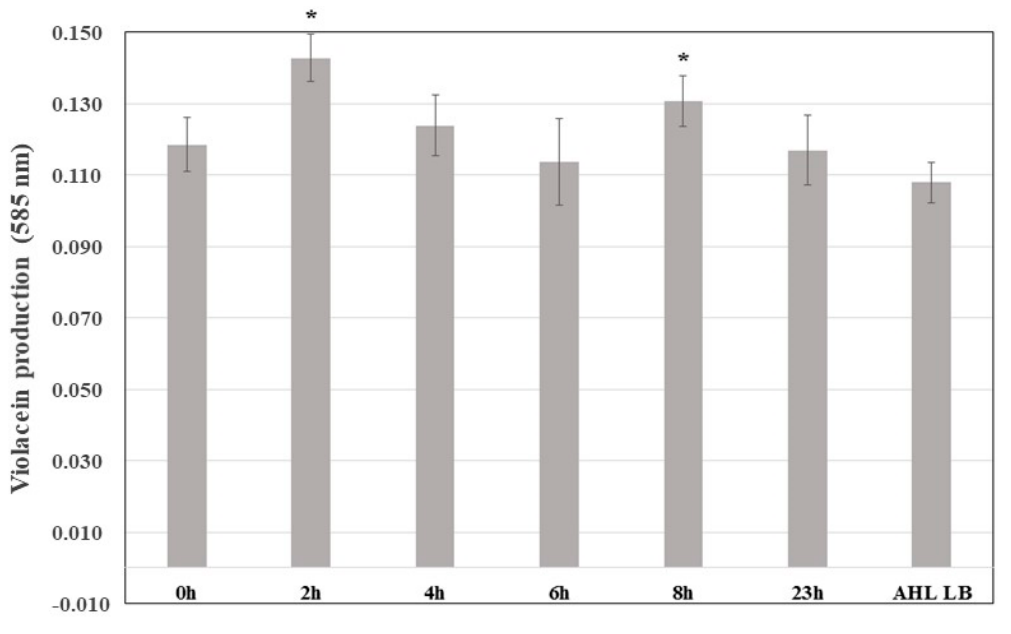
Figure 2. Kinetics of the production of C6-AHL in Klebsiella pneumoniae ATCC 13884 cultures. All samples were doped with 0.2 µg/mL C6-AHL; a control experiment was conducted but without K. pneumoniae ATCC 13884. * Statistically significative difference.